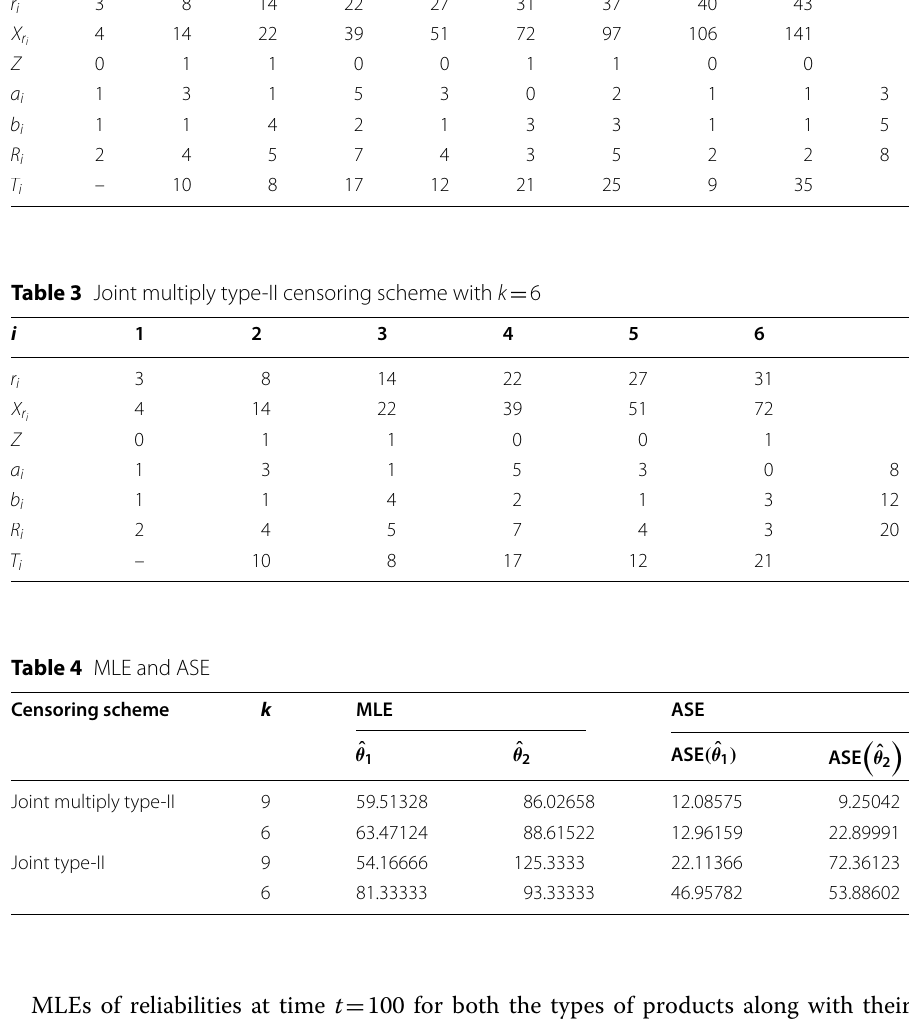
MLEs of reliabilities at time t 100 for both the types of products along with their = asymptotic standard errors are calculated using the Eqs. (11) and (12) and shown in the